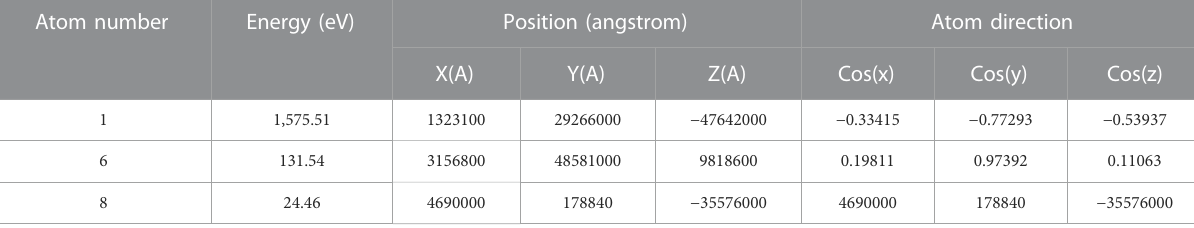
TABLE 1 Composition of Trim.dat fi le (PKA ’ s information) produced by GAMMATRACK program. Atom